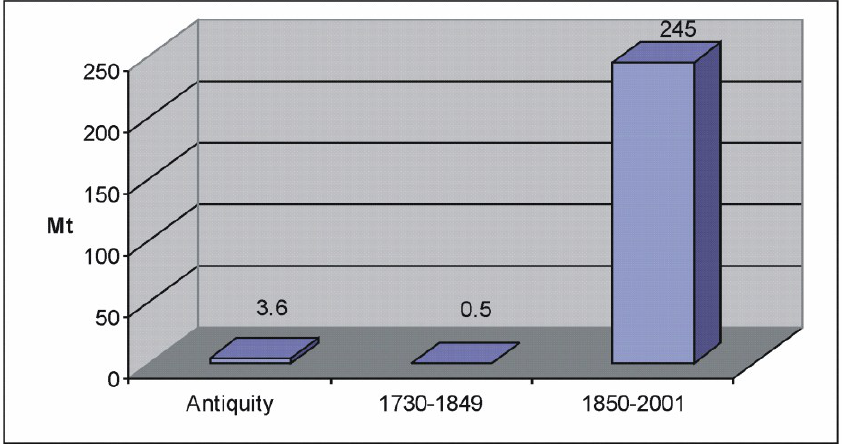
Figure 10. Sulphide production (run-of-mine ore) in the Río Tinto area throughout